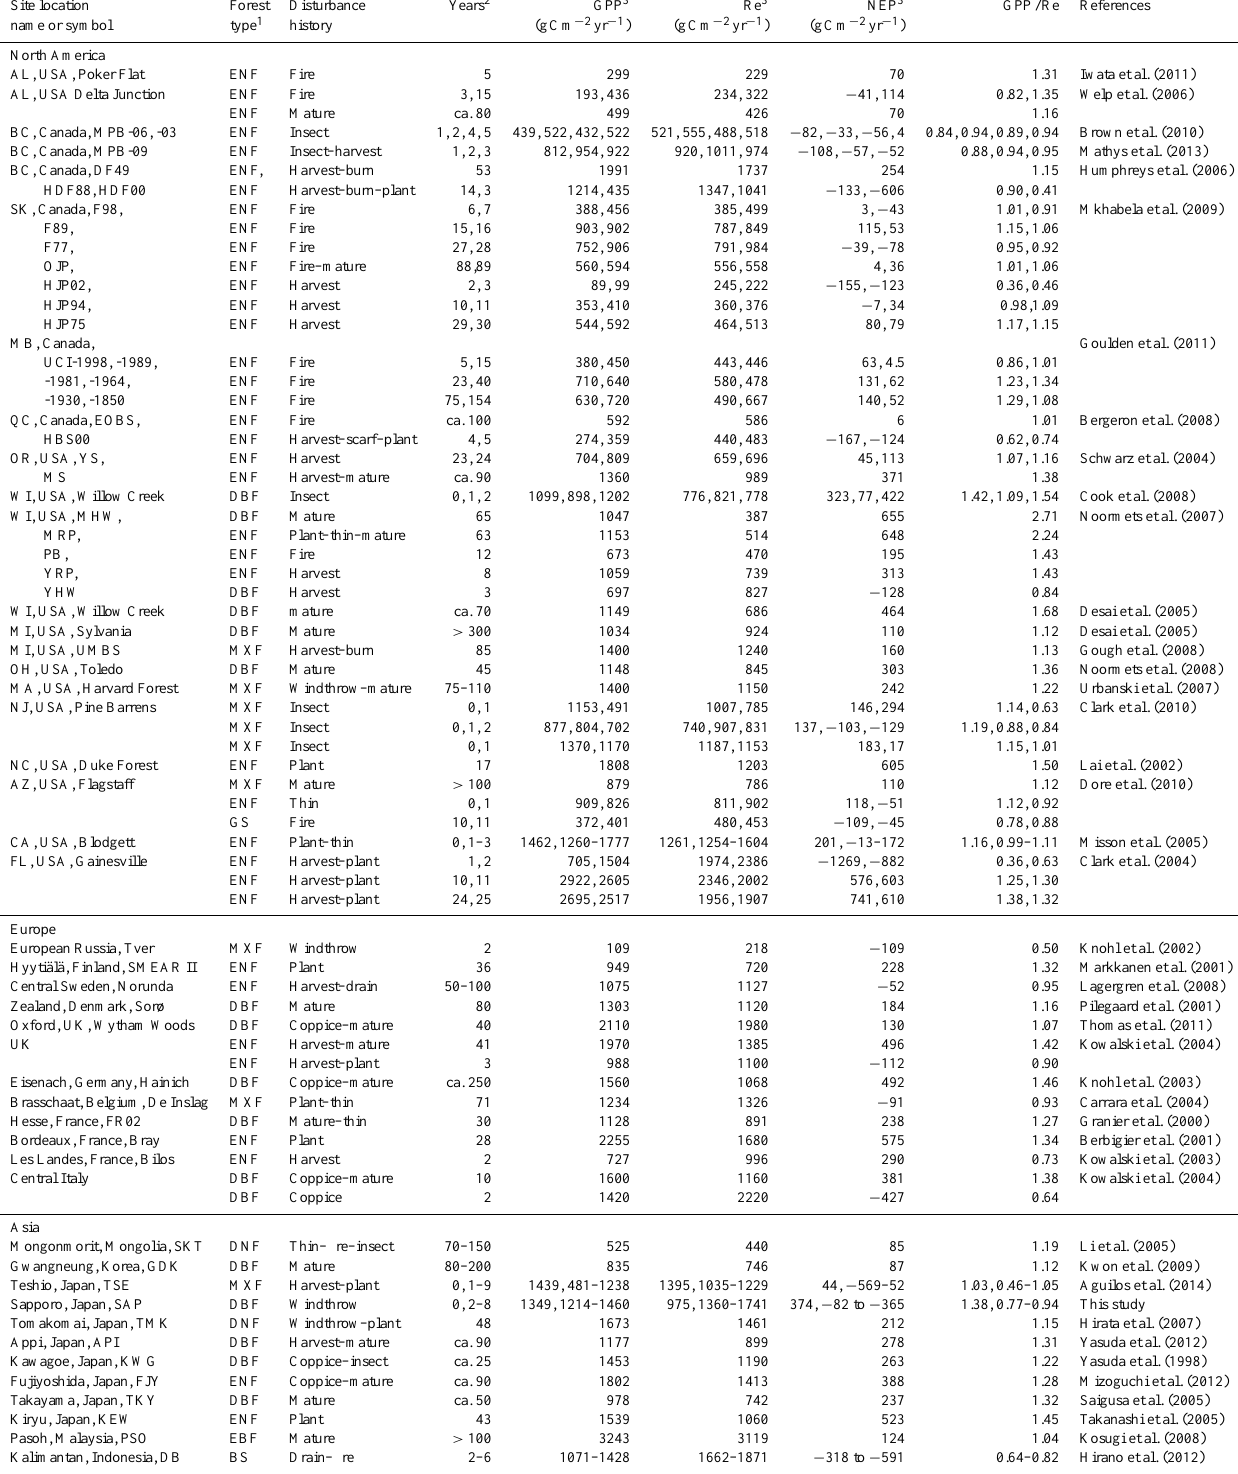
Table 3. Characteristics of the eddy covariance measurement in forest sites. Sites were selected with a focus on disturbance or management history. Some mature forest sites of a certain stand age were